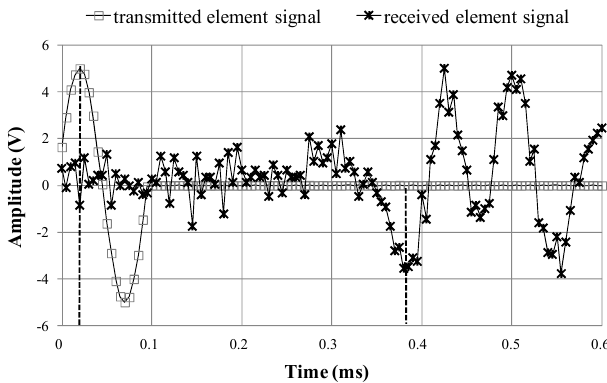
Figure 4. Non-desirable orientation of the top cap and base pedestal element.